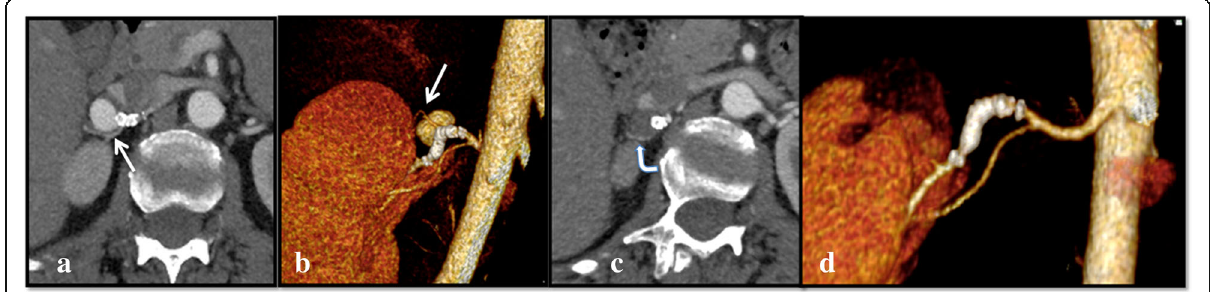
Fig. 5 a - d Coronal CTA ( a ) and 3D VR imaging ( b ) at 6 month FU, showing a patent sidebranch (arrow), which appears smaller in comparison to baseline CT and DSA (see above Figs. 1 and 2), directed to the upper pole of the kidney. c and d show the same finding at the 12-month FU: the sidebranch ostium is occluded as well as the aneurysm. However, the distal branching vessel is still patent (curved arrow), probably thanks to collateral